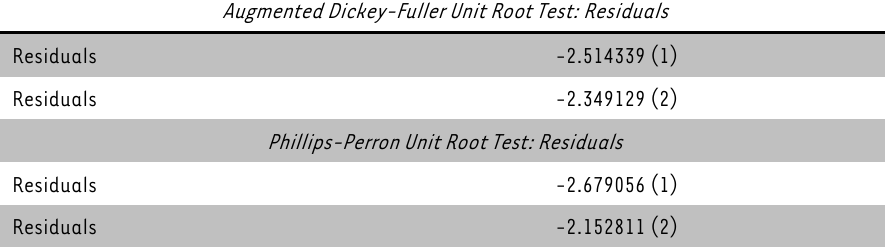
TABLE 3: Standard Cointegration (ADF Test on Residuals)